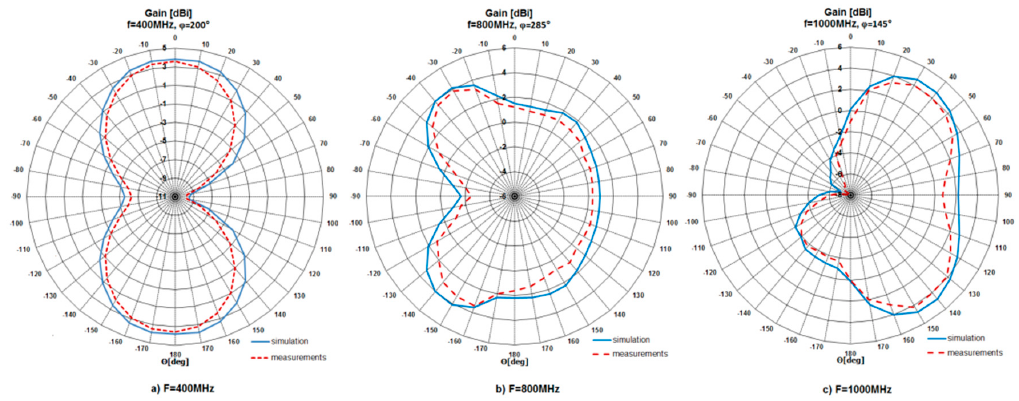
Figure 6. Simulated and measured radiation pattern in horizontal plane for different frequencies.